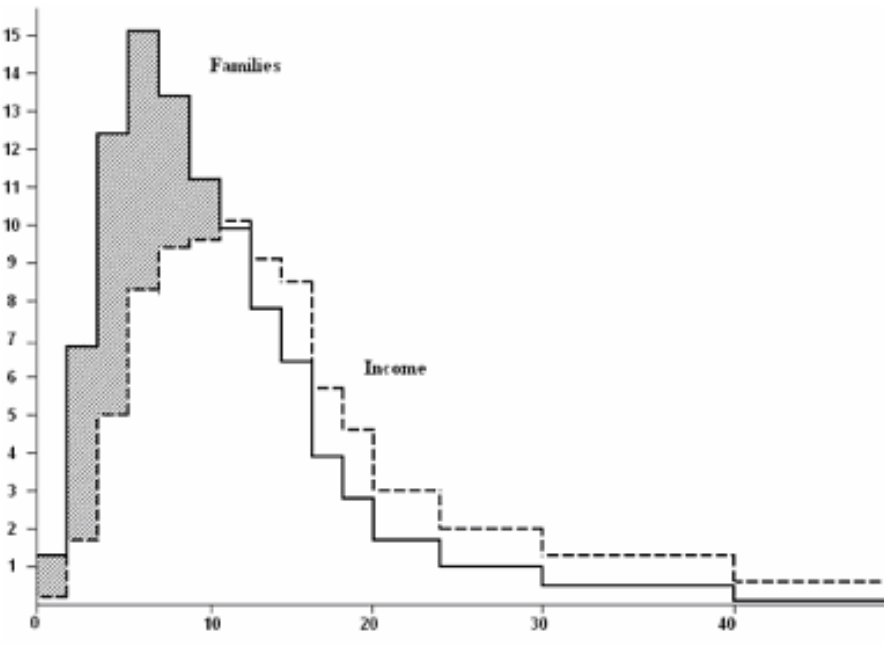
Figure 1 – Histograms for the distributions of frequencies and quantities, from data in Table